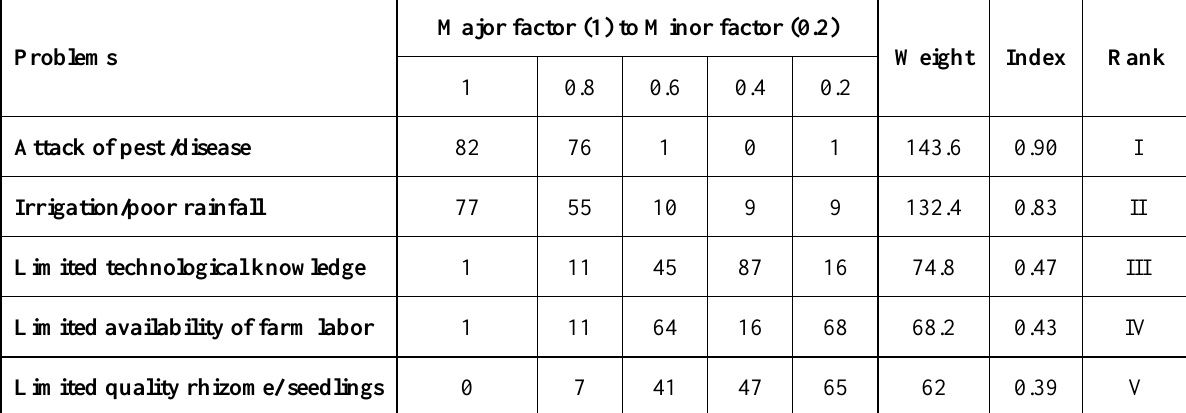
Table 13. Various production problems of LC farmers in the study area